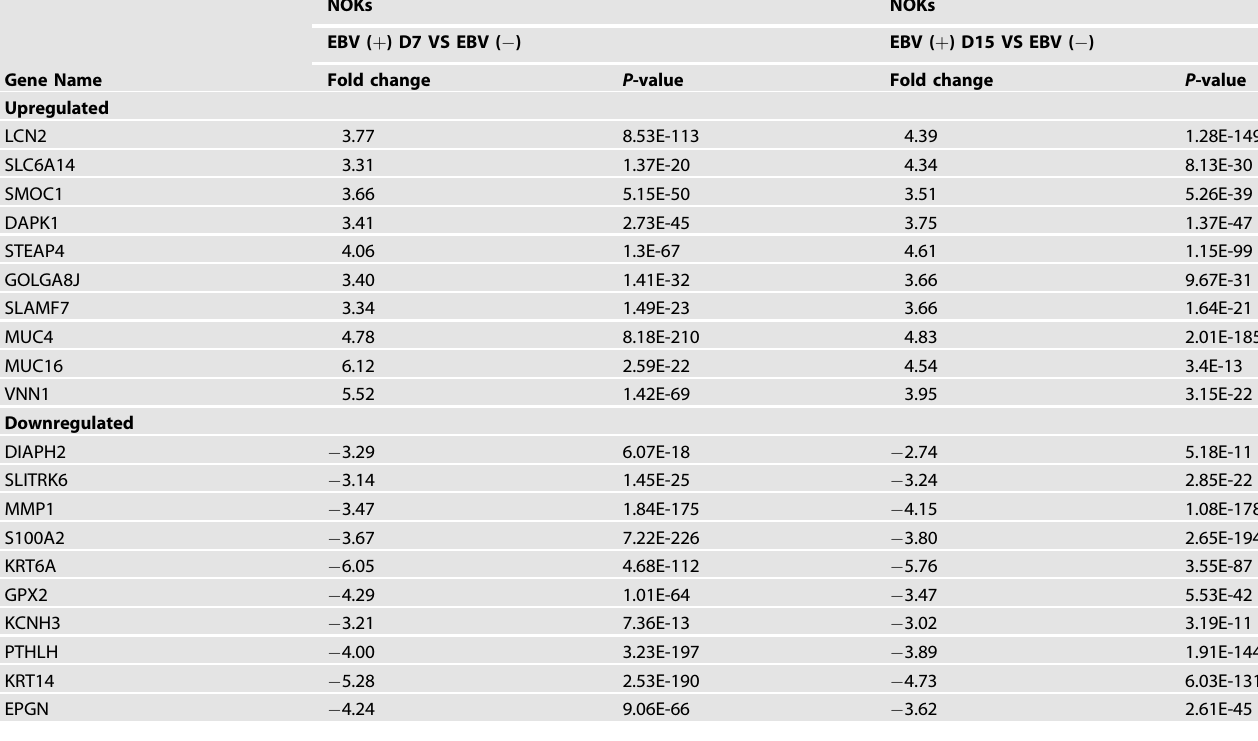
Table 3. Most signi fi cant differentially transcribed RNAs in NOKs after 7 and 15 EBV infection. NOKs